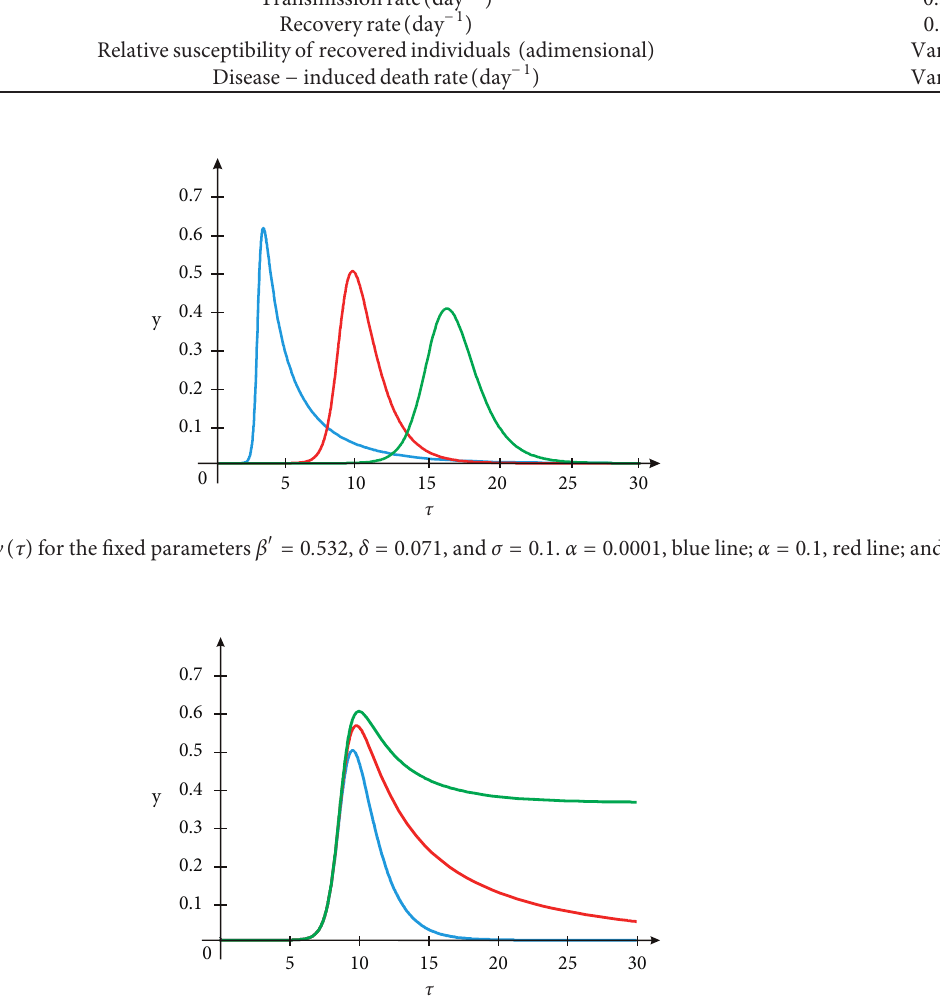
Figure 5: Evolution of y ( τ ) for the fixed parameters β ′ � 0 . 532, δ � 0 . 071, and α � 0 . 1. σ � 0 . 1, blue line; σ � 0 . 3, red line; and σ � 0 . 4, green